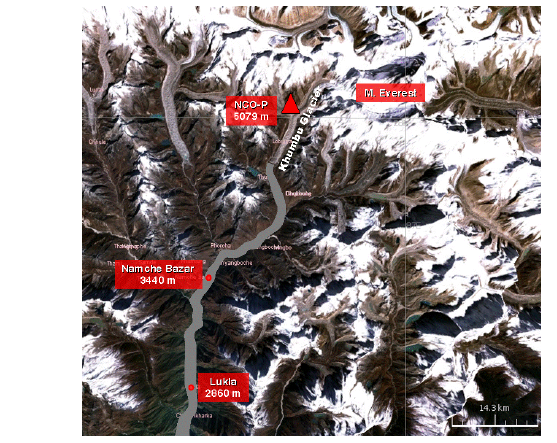
Fig. 1b. The Nepalese Khumbu valley (thick grey line) and NCO-P (red triangle). Modified by NASA World Wind, http://worldwind.